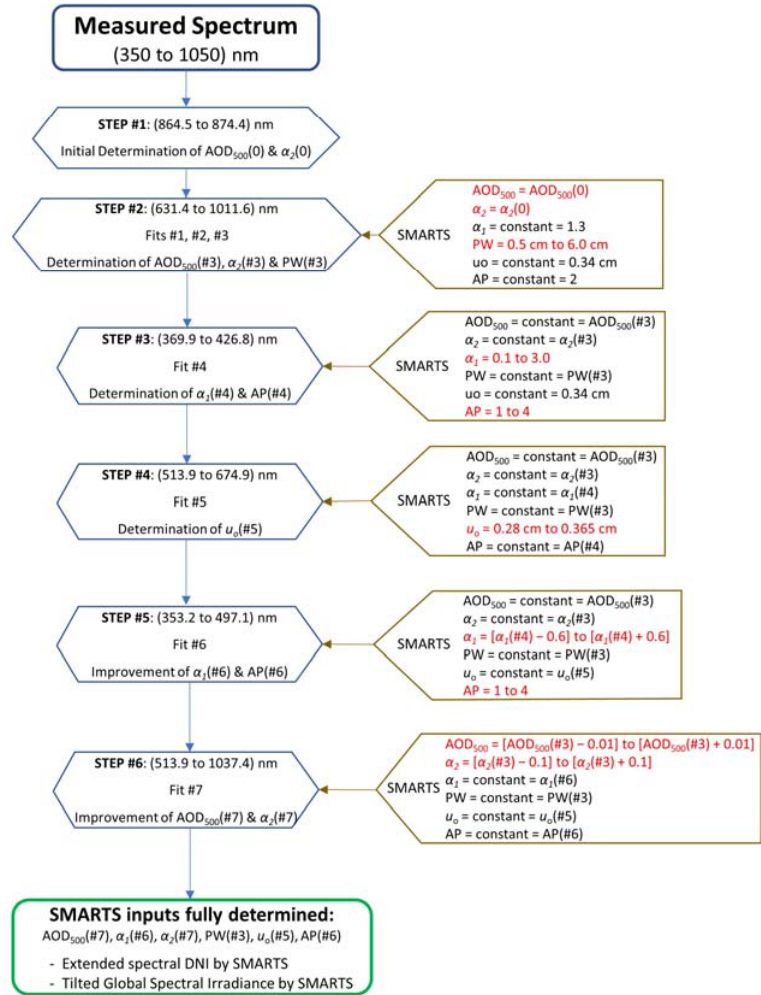
Figure 7. Flowchart of the methodology developed in this work. The measured spectrum is obtained with an EKO MS-700N spectroradiometer. Six steps are used to undertake seven fits where the input values of the SMARTS model are fixed iteratively to mimic the resulting modelled direct spectrum to the measured one. Once the inputs to SMARTS are determined, other spectral irradiance components of interest for the evaluation of PV technologies, such as the tilted global spectral irradiance, can be determined. The red letters in the brown boxes denote the SMARTS inputs to be varied in the fitting process, whereas the black letters correspond to those inputs with a constant value in the fitting process.